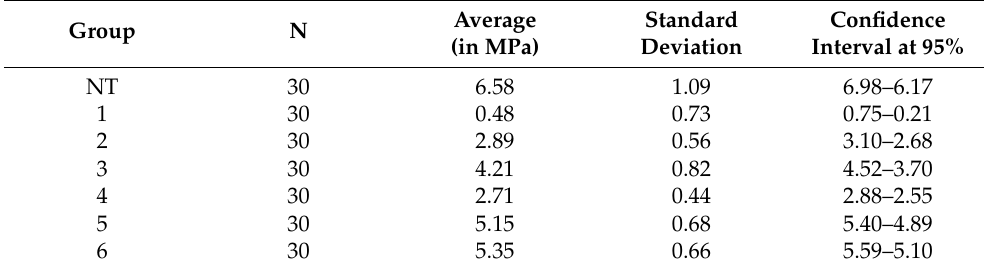
Table 1. Means of bond strength for the different groups. Group N